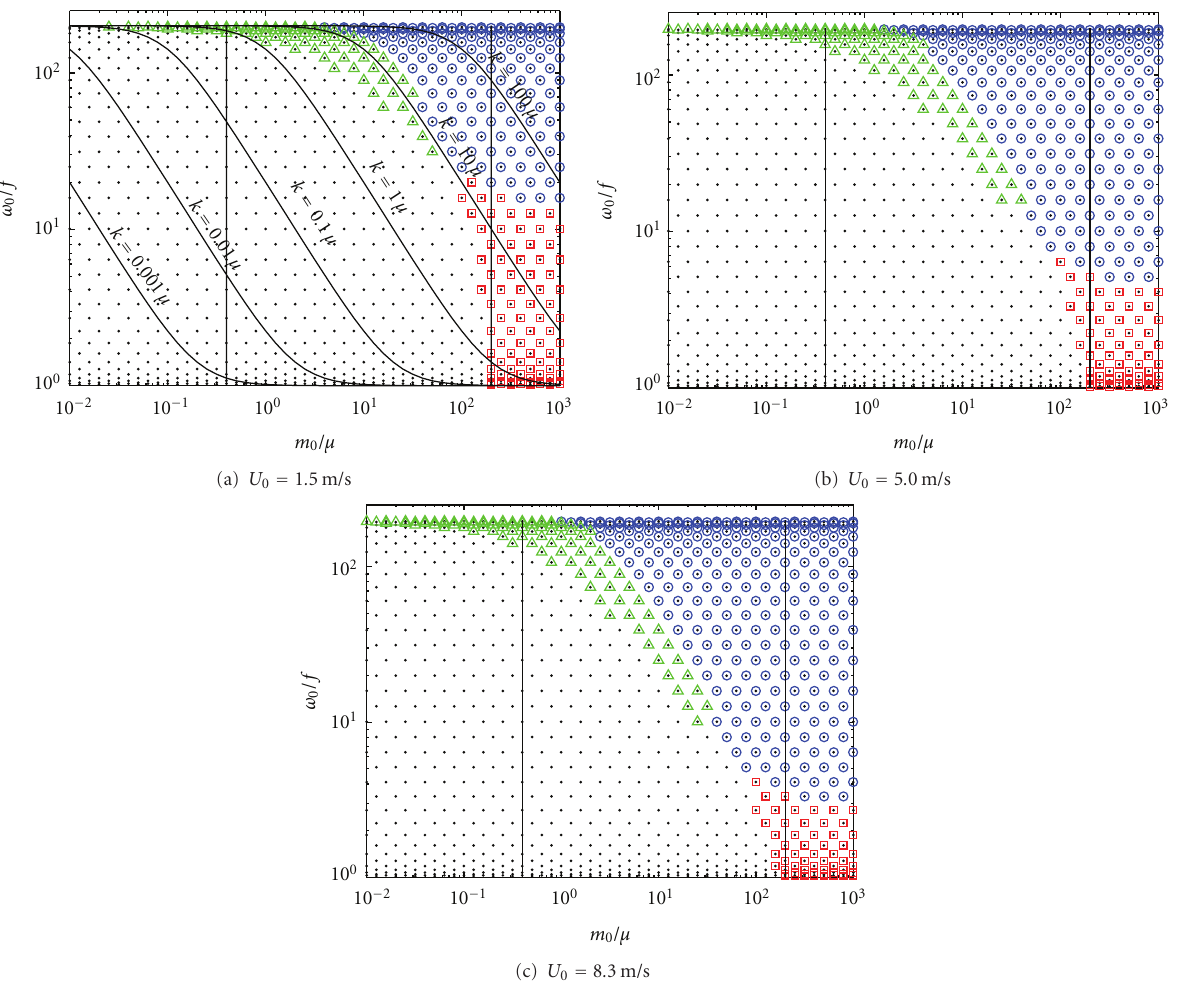
Figure 2: Probability of short waves reaching a turning point (green triangles), critical level (red squares), or either (blue circles) during propagation through an infinite inertia wavetrain. Lines on (a) represent constant k as labeled. Superimposed vertical lines depict wavenumber limits as discussed in the